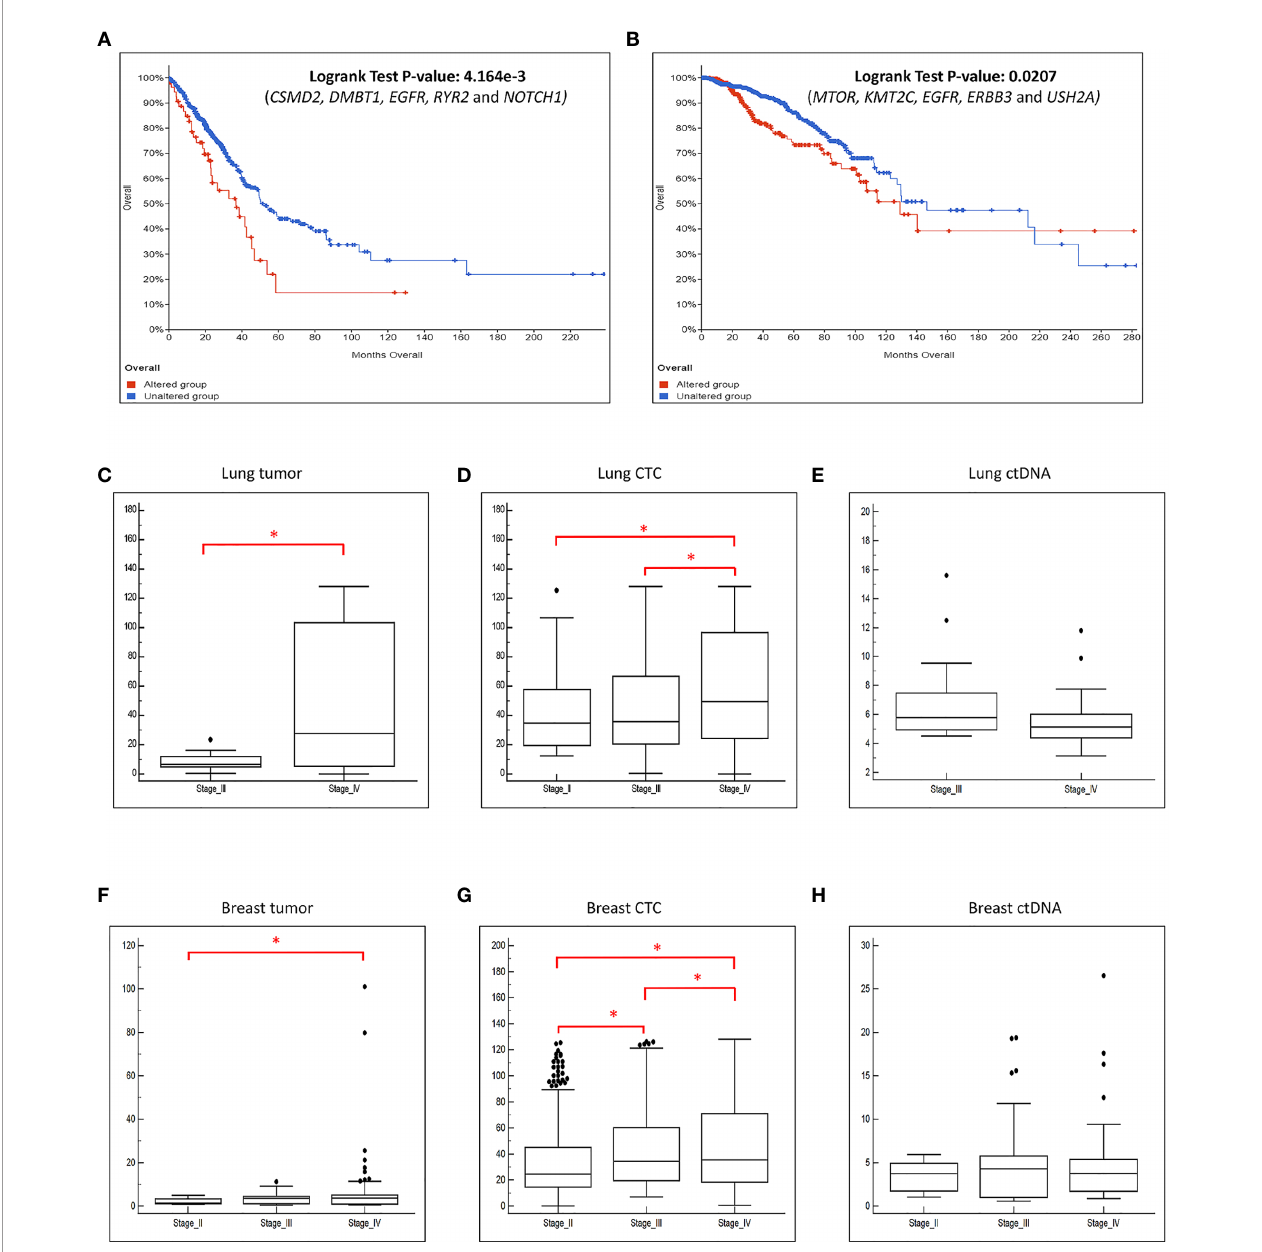
FIGURE 6 | The frequently altered genes found in this study are associated with worse survival outcome. We performed survival analysis using data obtained from cBioPortal with a large cohort of (A) lung and (B) breast cancer patients. X-axis represents time to event. Y-axis represents overall survival probability. The patients with mutated genes (red) have signi fi cantly poorer survival compared to patients without mutations (blue). The boxplot of the CNVs detected in the (C) tumor, (D) CTC and (E) ctDNA grouped by the disease stage for lung cancer patients. The boxplot of the CNVs detected in the (F) tumor, (G) CTC and (H) ctDNA grouped by the disease stage for breast cancer patients. There is signi fi cant increase of copy number changes (*p-value ≤ 0.05, t-test) when the disease progressed in the tumor and